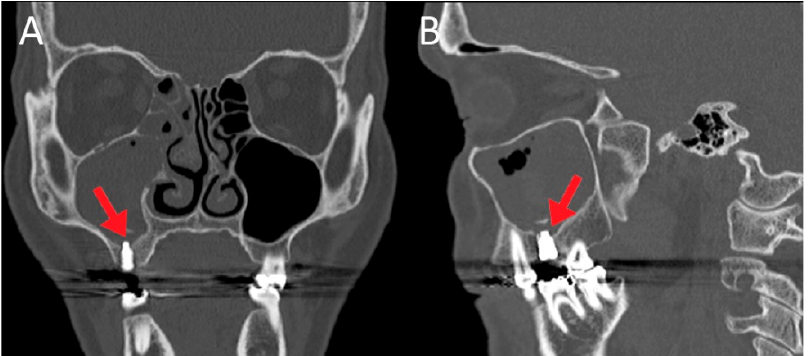
Figure 3. Female patient, 64 years old, who had undergone dental implant surgery 3 months earlier, complaining of left facial pain. CT ( A ): coronal scan; ( B ): sagittal scan) revealed odontogenic right maxillary sinusitis (red arrows indicate the dental implant). No migration of the dental implant was documented. An endoscopic primary surgical approach was proposed. The removal of implant removal was not